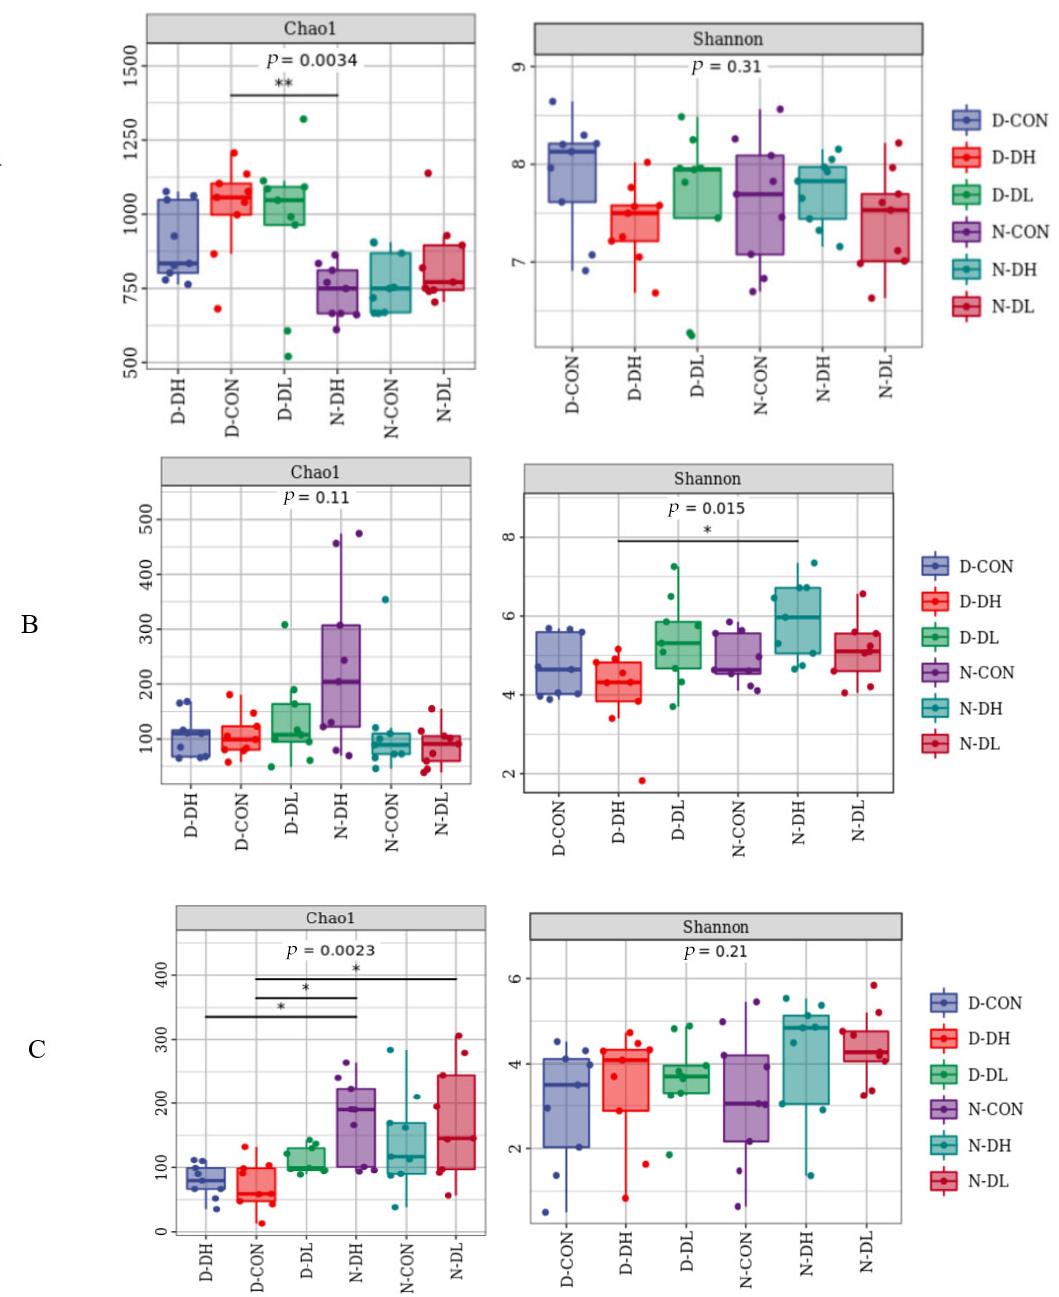
Figure 1. Diversity of rumen microflora in mutton sheep fed with different diets. * Stand for significant ( p < 0.05), ** stand for extremely significant ( p < 0.01).Based on the Shannon index and observations from the longitudinal changes in the intestinal microbial community of operational taxon units (OTUs), the meanings of symbols in the box line diagram are as follows: the upper and lower end lines of the box, and the upper and lower quartile range (IQR); Median line, median; Upper and lower edges, maximum and minimum values (extreme values within 1.5 times the IQR range); points outside the upper and lower edges represent outliers. The number under the diversity index label is the p -value of the Kruskal–Wallis test. ( A ) represents the alpha diversity index of bacteria, ( B ) represents the alpha diversity index of fungi, and ( C ) represents the alpha diversity index of protozoa. D − DH, D − CON, and D − DL represent the alpha diversity index of daytime of the DH,